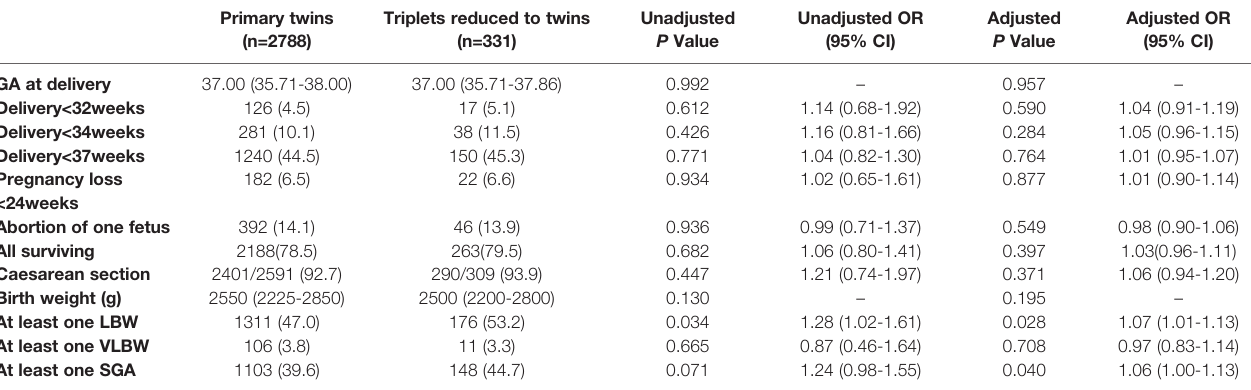
TABLE 4 | Pregnancy outcomes of triplets reduced to twins versus primary twins.